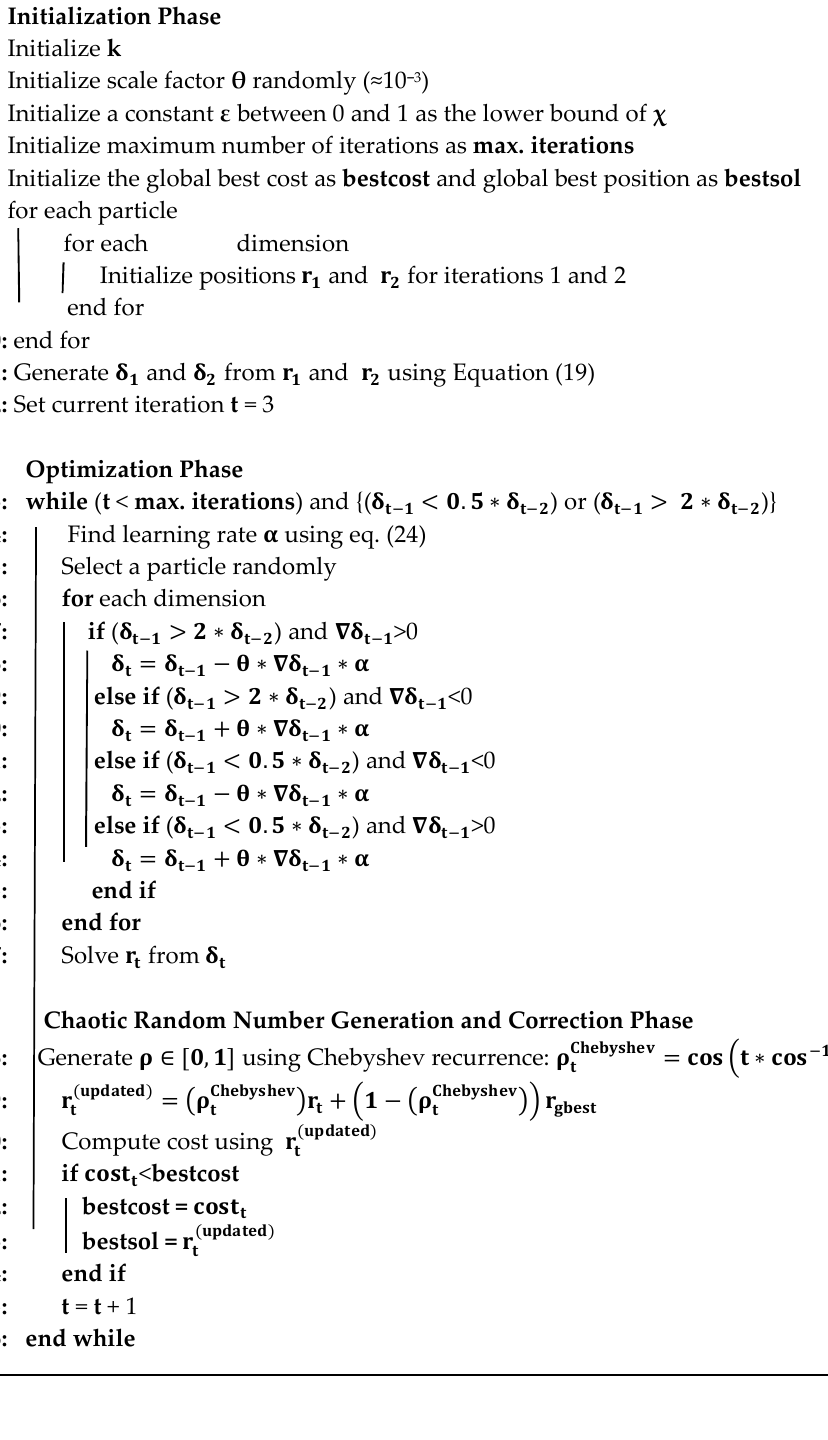
Algorithm 1. Quantum Double Delta Swarm Algorithm J. Sens. Actuator Netw. 2018, 11, x FOR PEER REVIEW 8 of 30 Initialization Phase